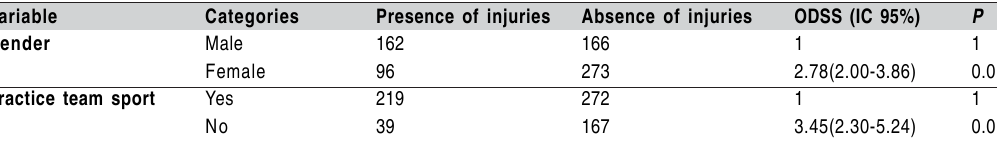
Table 3. Distribution of university students according to gender, team sport practice and presence of orafacial injuries. Joaçaba, SC, Brazil.